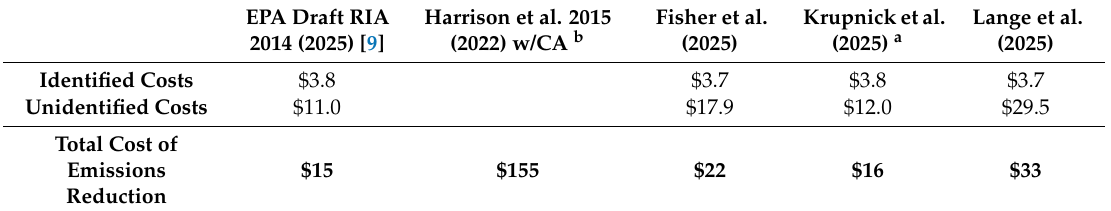
Table 4. Monetized Cost of Tons of NO x Mitigation (in billions 2011 $) (compliance year in